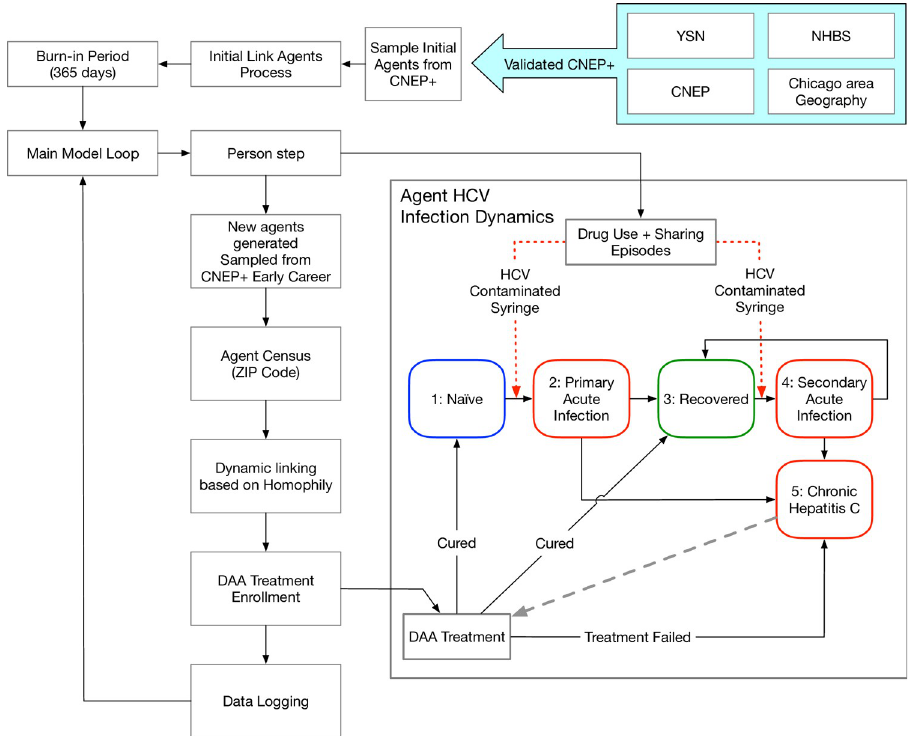
Fig 1. Schematic diagram of the Hepatitis C Elimination in PWID (HepCEP) model. The initial synthetic model population is generated from the CNEP+ dataset and linked in a syringe-sharing network. After the model burn-in period of 365 days, the main model loop begins and each individual PWID agent executes their step behavior that in turn simulates the HCV infection dynamics. PWID who have completed a successful treatment will return to either the NAI¨VE or RECOVERED state depending on if they have previously recovered from an acute infection. When a PWID is cured, the model uses a CURED state but remembers past RECOVERED state or past NAI¨VE state and returns the PWID to the respective state after